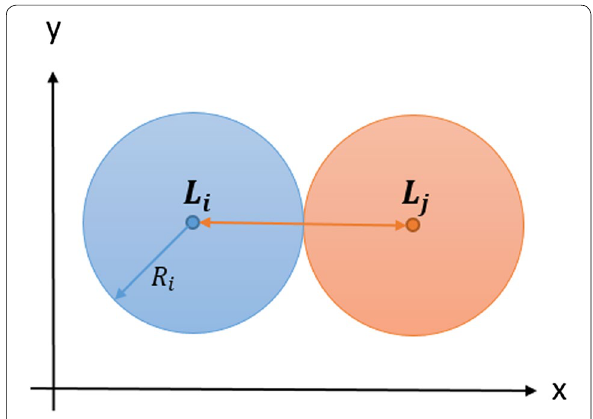
Fig. 3 Illustration of the proposed weight associated to each sample: a disc centered on the spot hit with the hammer with a radius half of the Euclidian distance to the nearest neighbor. This intends to symbolize the area around the sample where it is relevant, i.e. where it could be assumed that the returned sound would be extremely similar to the one collected. The value of the radius was chosen in order to avoid